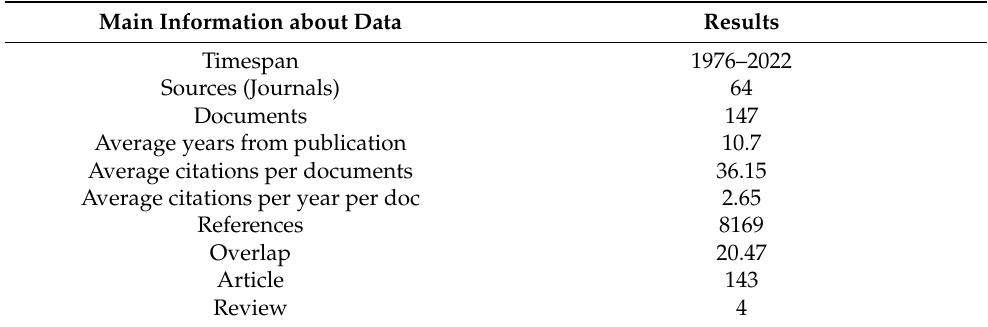
Table 1. Key information about the obtained data after the double-stage screening process.